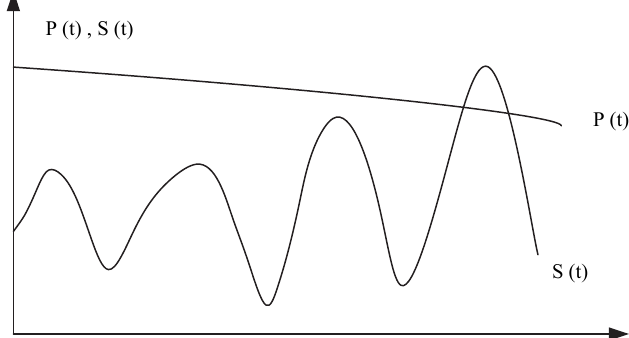
Figure 1. Changes of resistance and